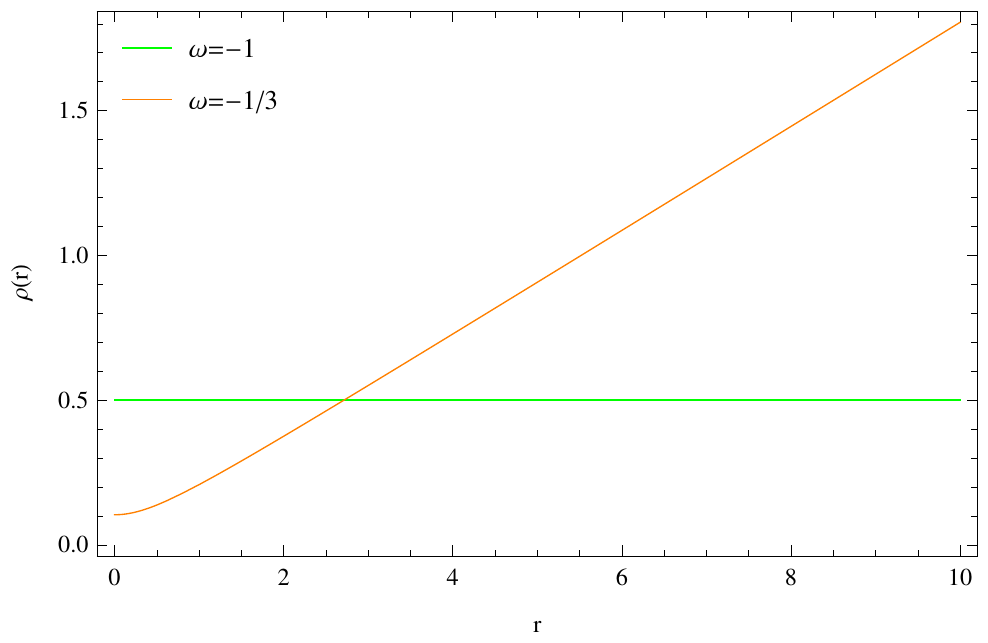
Figure 4. The density is plotted against the radial parameter r , for both dark energy matter ( ω = − 1) and quintessence field ( ω = − 1/3), for the values of constants C 1 = 0.01, C 2 = 0.5, C 3 = 2. The radial profile of the Ricci scalar for λ = − 0.1 is plotted in Figures 5 and 6. The Ricci scalar is observed to be negative and constant in Figure 5 (dark energy matter), whereas it is negative and decreasing in Figure 6 (quintessence matter).